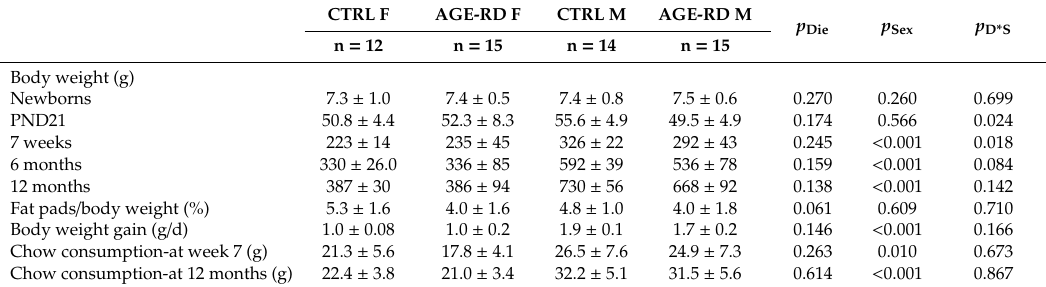
Table 2. F2 o ff spring: Body weight and chow consumption.